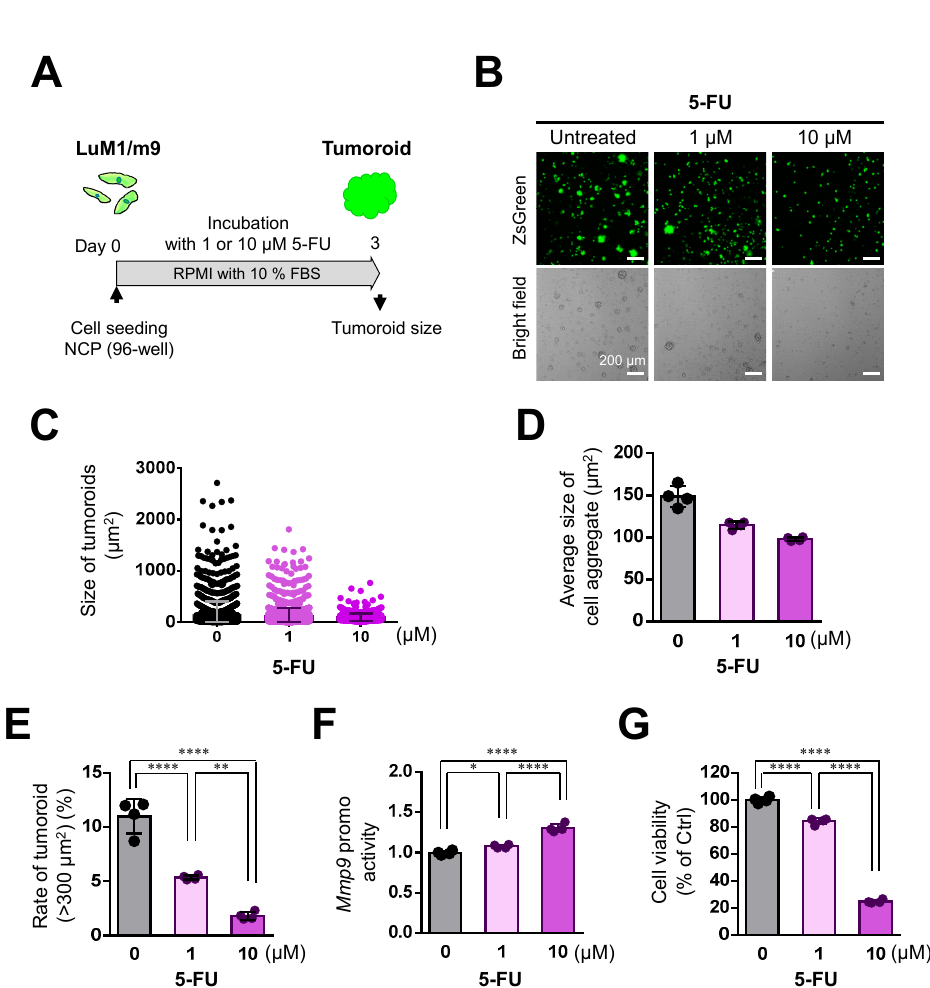
Figure 7. 5-FU inhibited the tumoroid growth of mCRC, although not completely: ( A ) a scheme of the experimental protocol used for panel ( B – G ). LuM1/m9 cells were cultured with 5-FU at 0, 1, or 10 μ M for 3 days in a medium containing 10% FBS; ( B ) representative images of cell aggregates of LuM1/m9. Scale bars, 200 μ m 2 ; ( C ) column scatters plotting of tumoroid size. Representative data from a single well were shown; ( D ) the average size of cell aggregates. n = 4 independent culture wells; ( E ) the rate of tumoroids larger than 300 μ m 2 . n = 4 independent culture wells; ( F ) Mmp9 promoter activity. n = 4 independent culture wells; and ( G ) cell viability. n = 4 independent culture wells. * p < 0.05, ** p < 0.01, **** p < 0.0001.